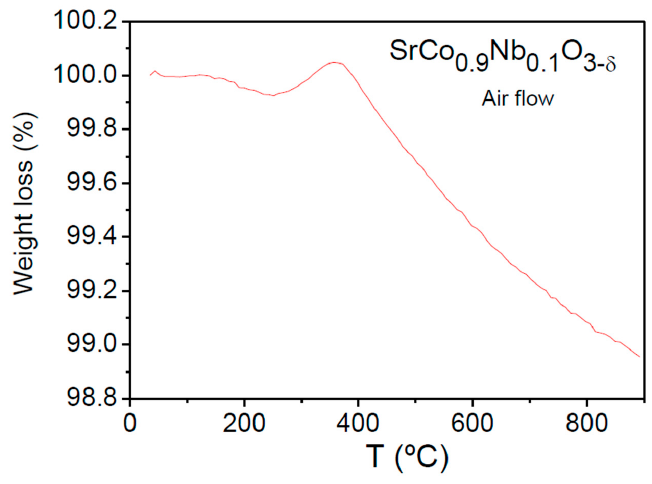
Figure 4. Thermogravimetric analysis (TGA) curve of SrCo 0.9 Nb 0.1 O 3 − δ in air flow.